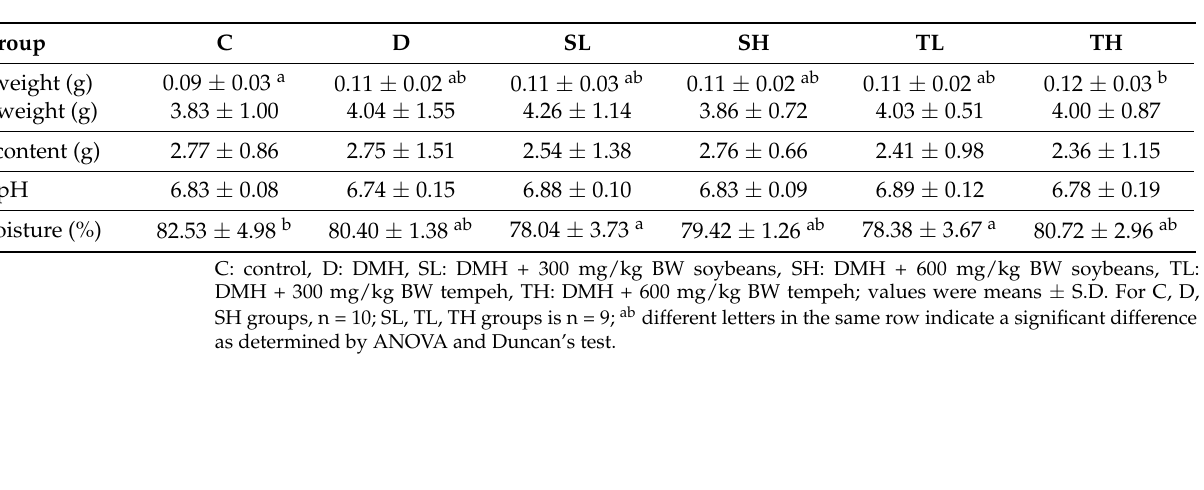
Table 2. Comparisons of colon weight, cecal weight, cecal content, pH, and fecal moisture among